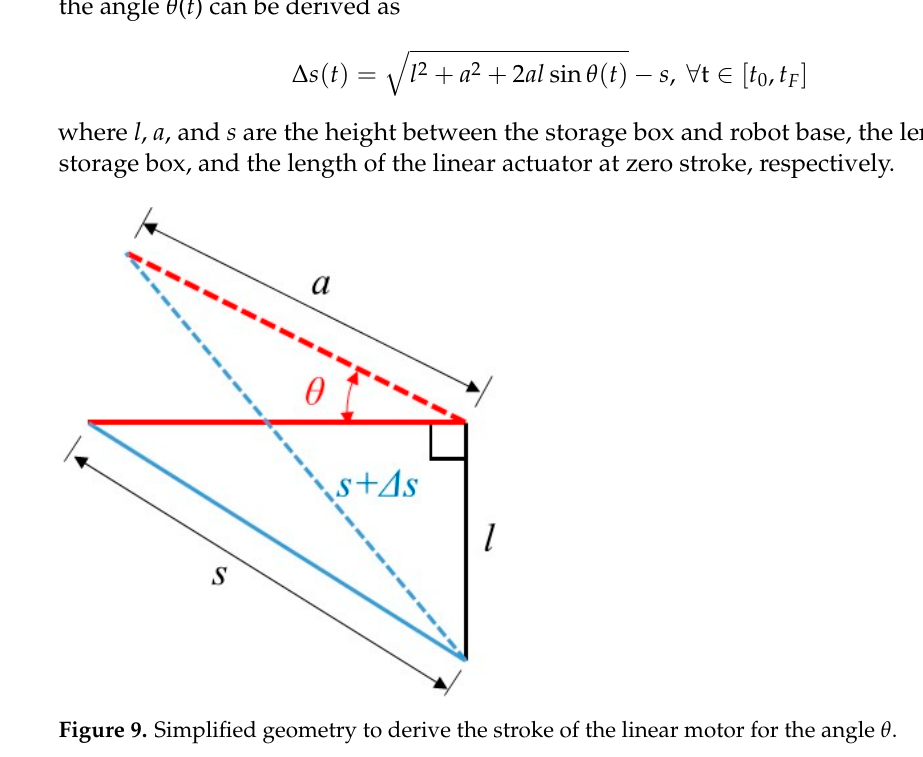
Figure 10. Block diagram of the robot motion control algorithm to reach human survivors.